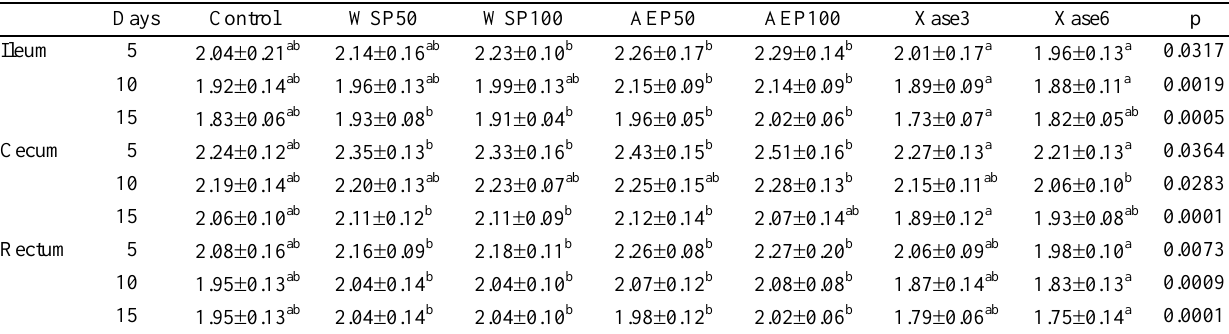
Table 3. Effects of pentosan and xylanase on digesta viscosity in the gut (Pa  s) Days Control WSP50